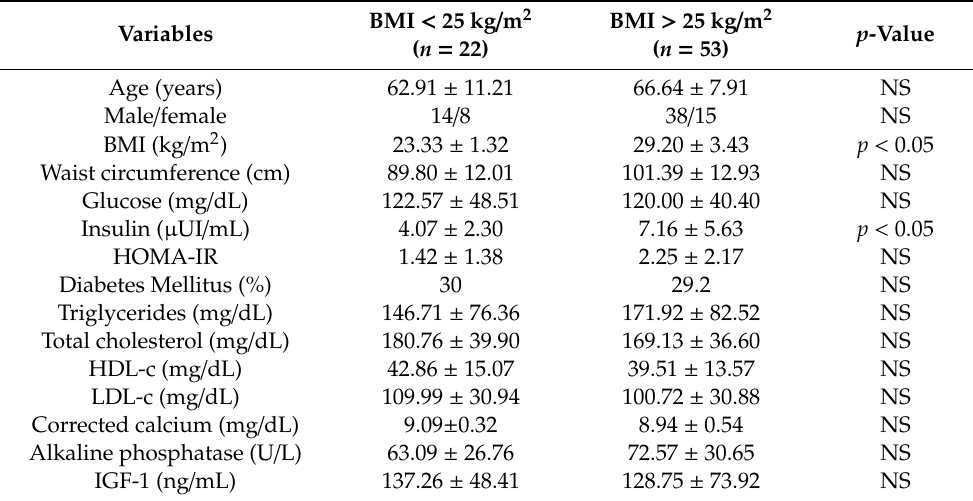
Table 1. Baseline clinical, anthropometrical, and biochemical variables of the colorectal cancer (CRC) patients, according to the body mass index (BMI). Data are expressed as mean ± standard deviations or